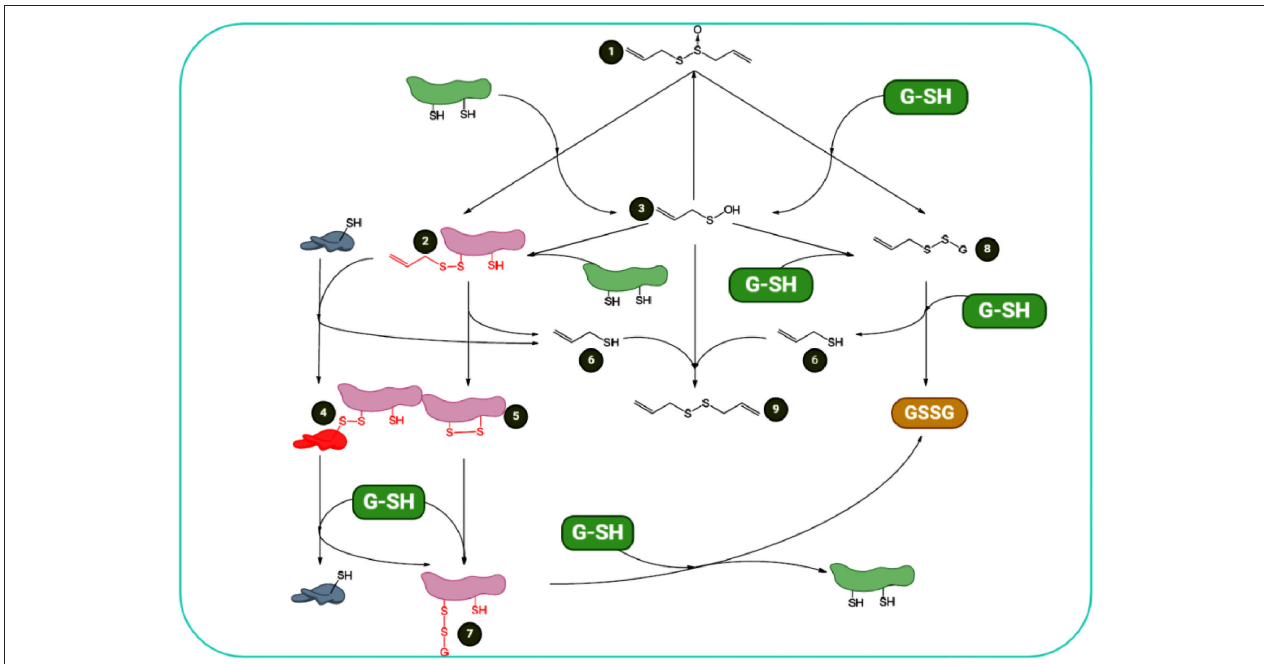
FIGURE 3 | Summary of allicin and cellular thiols: redox chemistry of allicin shows that (1) it can react with cellular thiols such as Cys-containing proteins and GSH. Its reaction with proteins results in formation of S-allyl-mercapto-proteins (2) and allyl sulfenic acid (3). S-allyl-mercapto-proteins can react with other proteins via disulfide bond-stabilized complexes (4) or generate intramolecular disulfide bonds (5). Both reactions result in the elimination of allyl mercaptan (6). Protein disulfide bonds are reducible by cellular GSH, resulting in S-glutathionyl-mercapto-proteins (7). To omit the glutathionyl residues from the proteins, another GSH is required. Additionally, allicin reacts with GSH. This interaction results in S-allyl-mercapto- GSH (8) and allyl sulfenic acid (3). S-allyl-mercapto-GSH can undergo a thiol/disulfide exchange reaction with an additional GSH to form allyl mercaptan and glutathione disulfide (GSSG) (6). Allyl sulfenic acid (3), formed upon direct reactions of thiols and allicin, can react with proteins to form S-allyl-mercapto-proteins (2), with GSH to form S-allyl-mercapto-GSH (8), with allyl mercaptan (6) to DADS (9), or with additional allyl sulfenic acid (3) to produce allicin de novo . This figure adapted from Borlinghaus et al. (24).